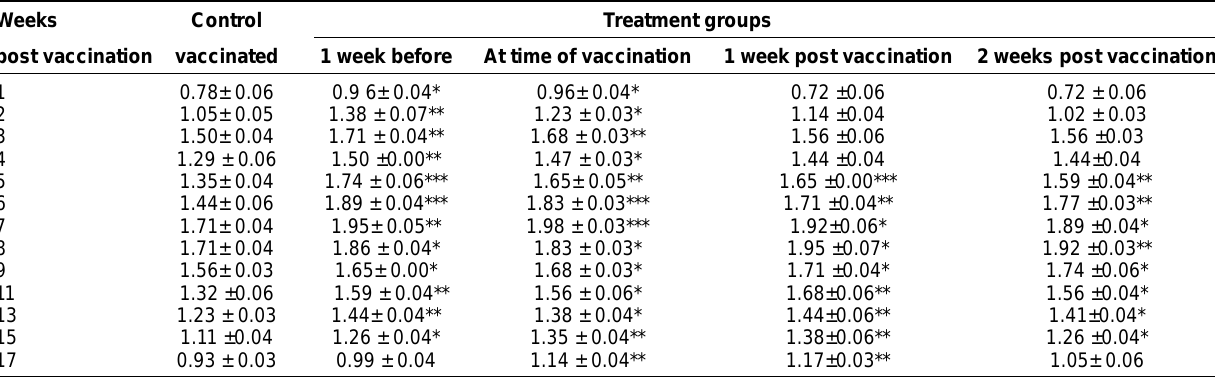
Table-4. Effect of intramuscular injection of Imidocarb dipropionate (3mg/Kg b.wt.) on the Log10 of antibody titre using ELISA test in anaplasmiod- infected calves vaccinated with FMD vaccine (±S.D.,n=5).